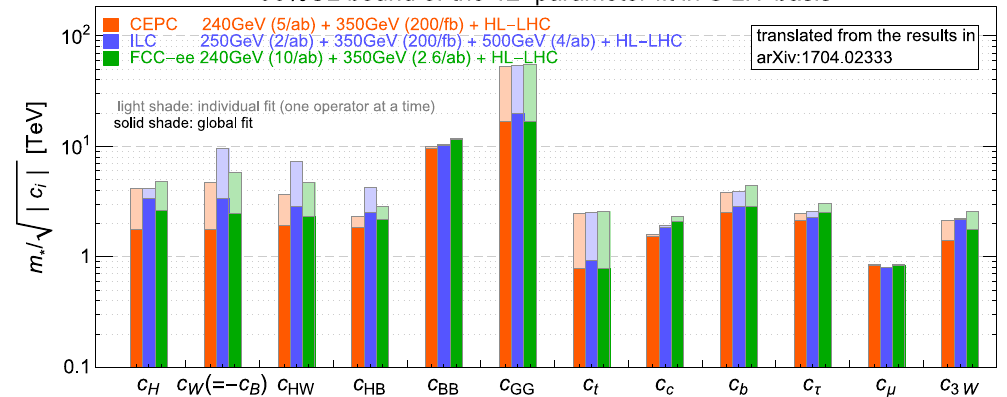
Figure 12 . The 95% C.L. constraints on the overall coe(cid:14)cient of O i from ref. [38], which are p translated into the SILH basis and presented in the form m (cid:3) = c i . Estimated Higgs measurement precision from CEPC, ILC, and FCC-ee are used with the inclusion of HL-LHC Higgs precision. better diphoton statistics and ttH processes that compliment Higgs factory